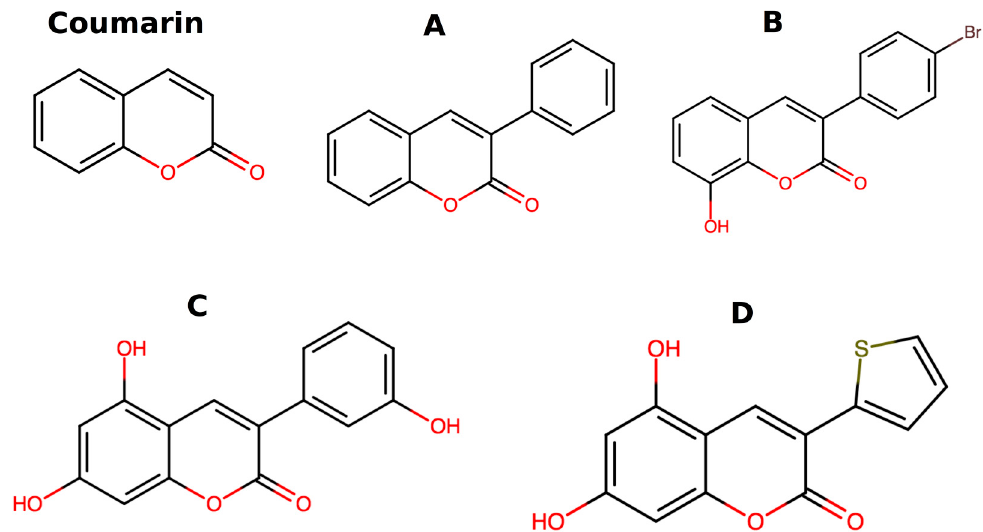
Figure 1. Chemical structure of coumarin, 3-phenylcoumarins ( A – C ), and 3-heteroarylcoumarin derivatives ( D ) are shown here.